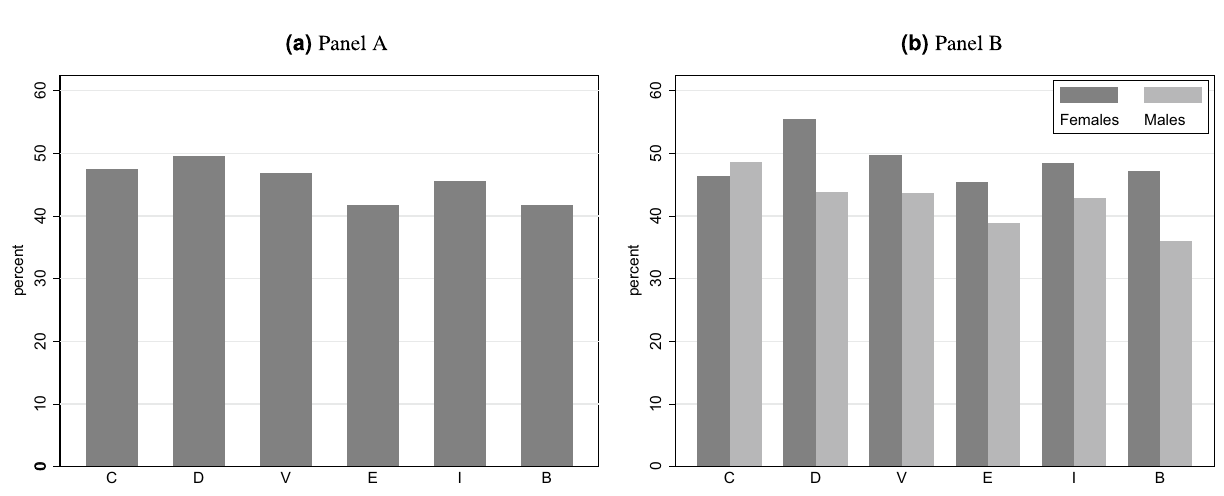
Figure 1. Donation rate across